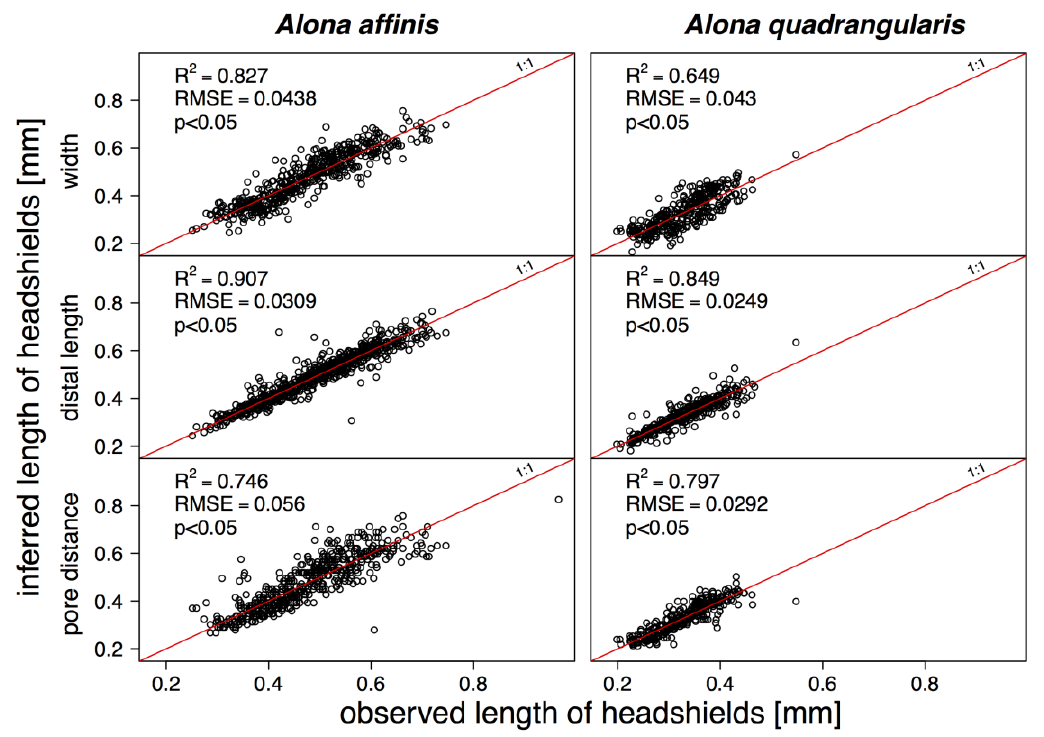
Figure A1. Inferred headshield length of Alona species. Water 2020 , 12 , x FOR PEER REVIEW